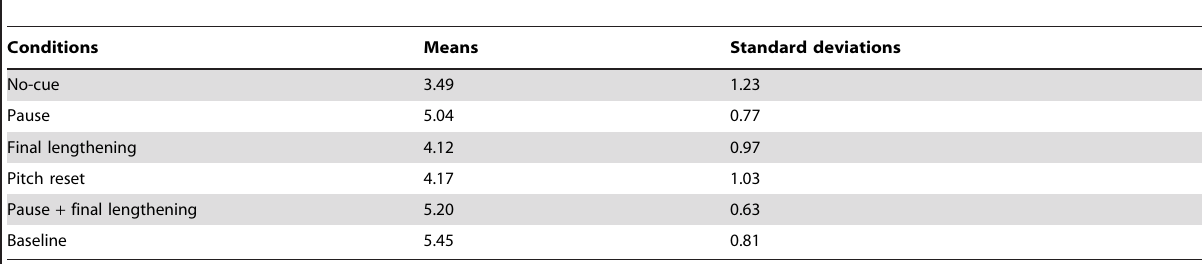
Table 2. Naturalness rating scores for the six